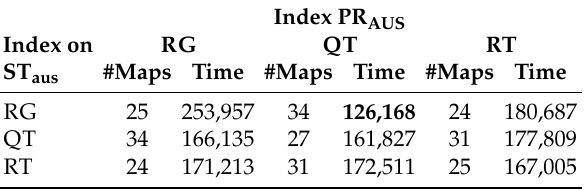
Table 8. Result of experiments with joins on real datasets regarding the primary roads and the states of Australia.